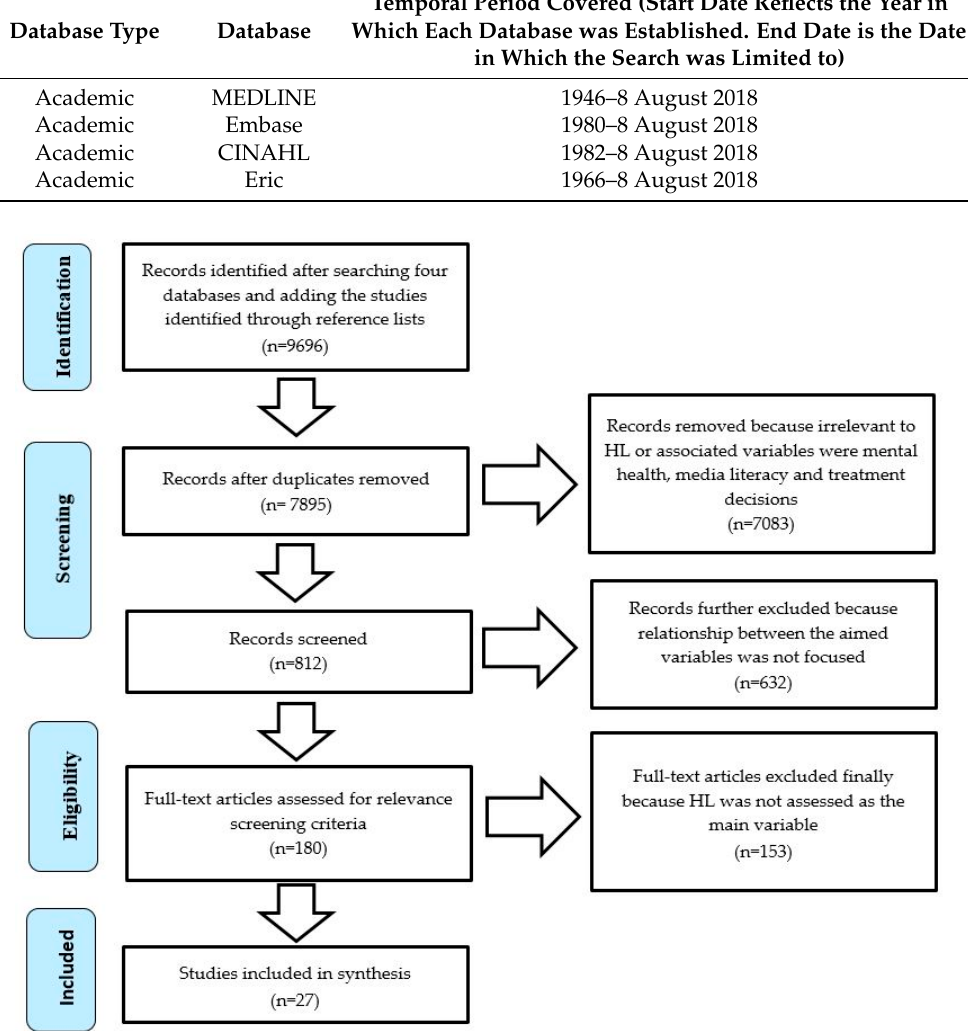
Figure 1. PRISMA flow chart for search process.